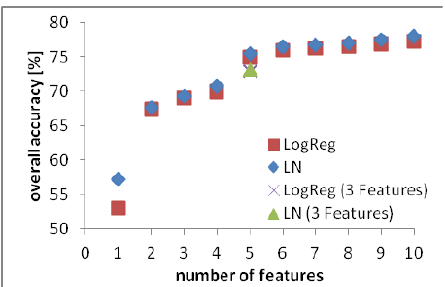
Figure 6: Results with (left) and without (right) nDSM value as classification